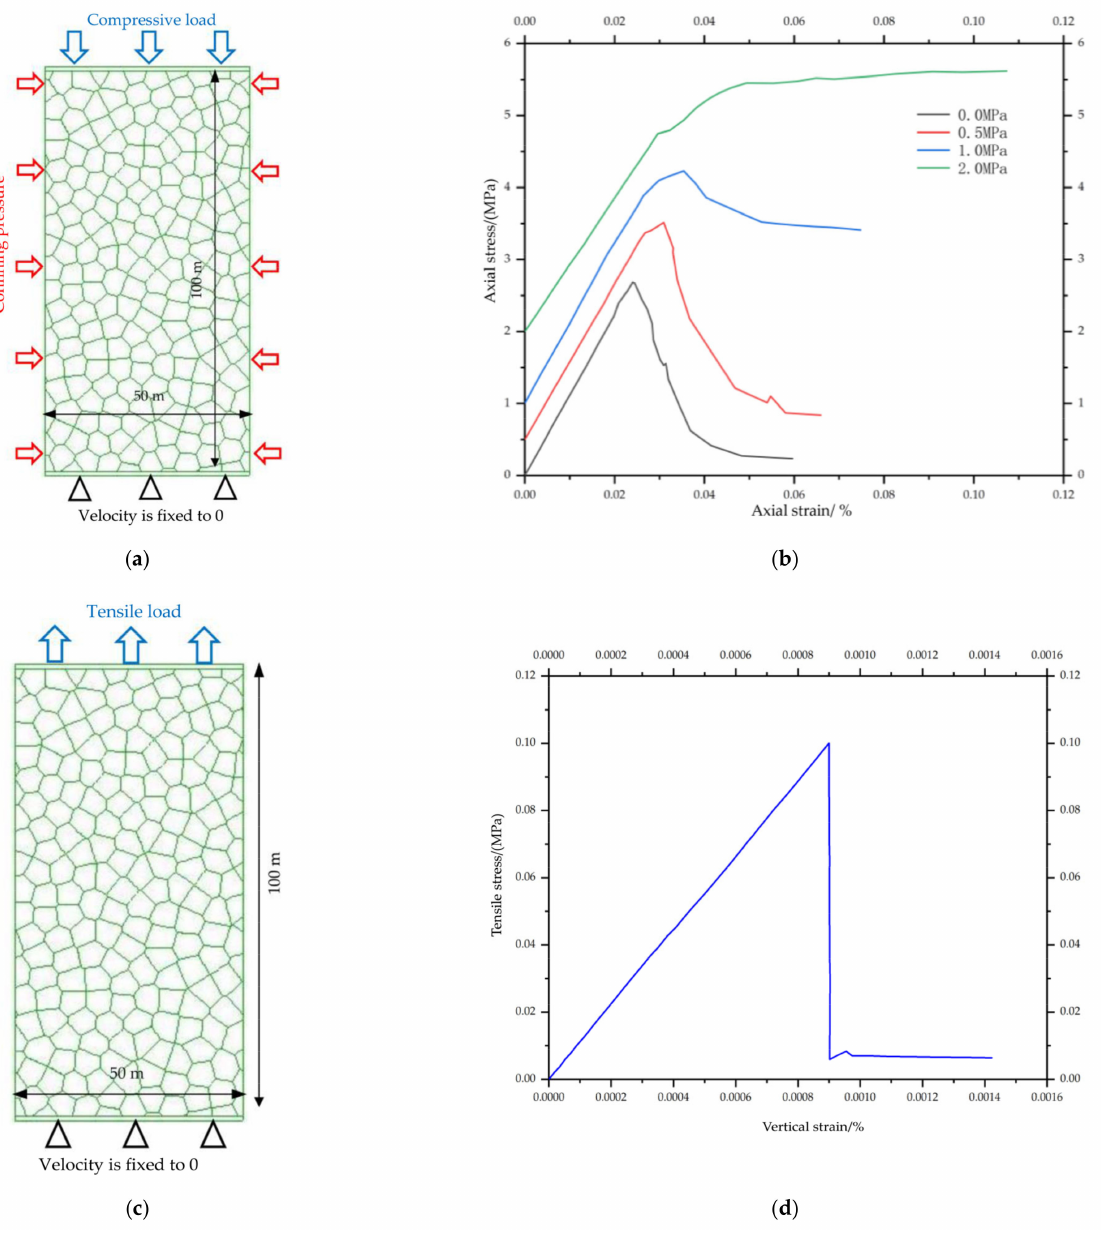
Figure 8. Calibration of the UDEC Voronoi model. ( a ) Compression test model; ( b ) axial stress–strain curves obtained from unconfined and confined compression tests (i.e., using confining pressures of 0, 0.5, 1.0, and 2.0 MPa); ( c ) tensile test model; and ( d ) the results of a direct tensile test showing the stress–strain curve